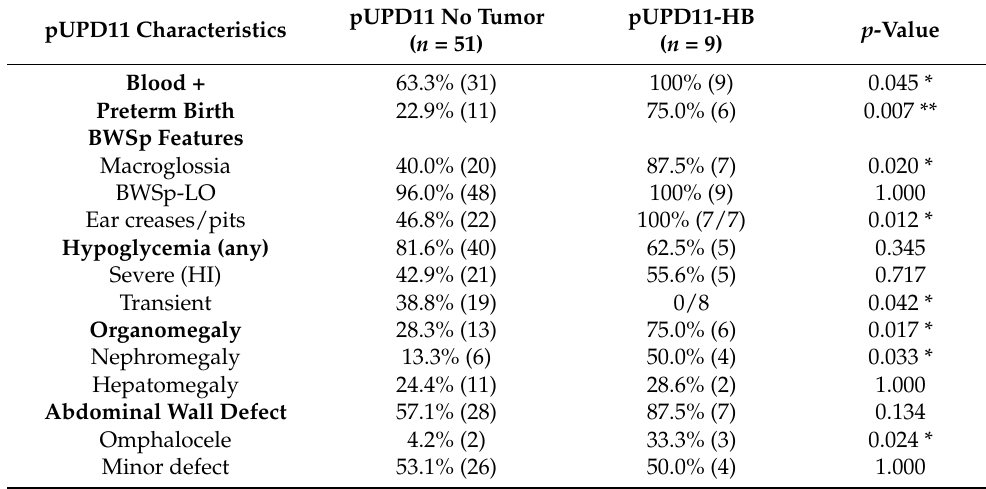
Table 11. Hepatoblastoma (HB)-associated phenotypes within pUPD11 population. pUPD11